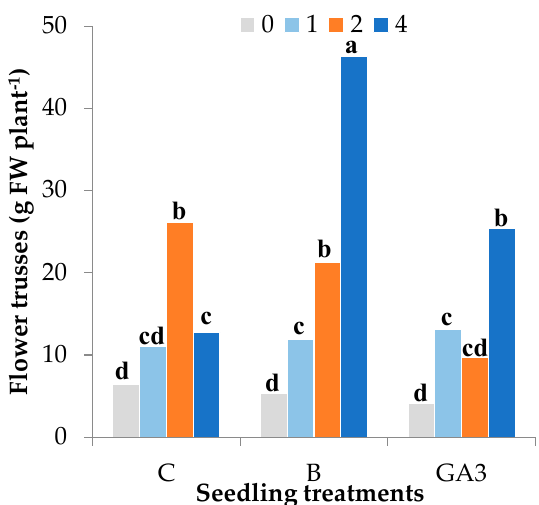
Figure 10. Effect of the seedling treatments (C, untreated control, B, bacterial biostimulant, GA3, gibberellic acid spray 10 − 5 M) and the nursery fertigation rates (0, 1, 2 and 4 g L − 1 of NPK 20-20-20) on the fresh weight of Solanum lycopersicum ‘Marmande’ flower trusses (racemes, flowers, and small fruits) (bars with different letters are significantly different at p < 0.05 according to the LSD test).